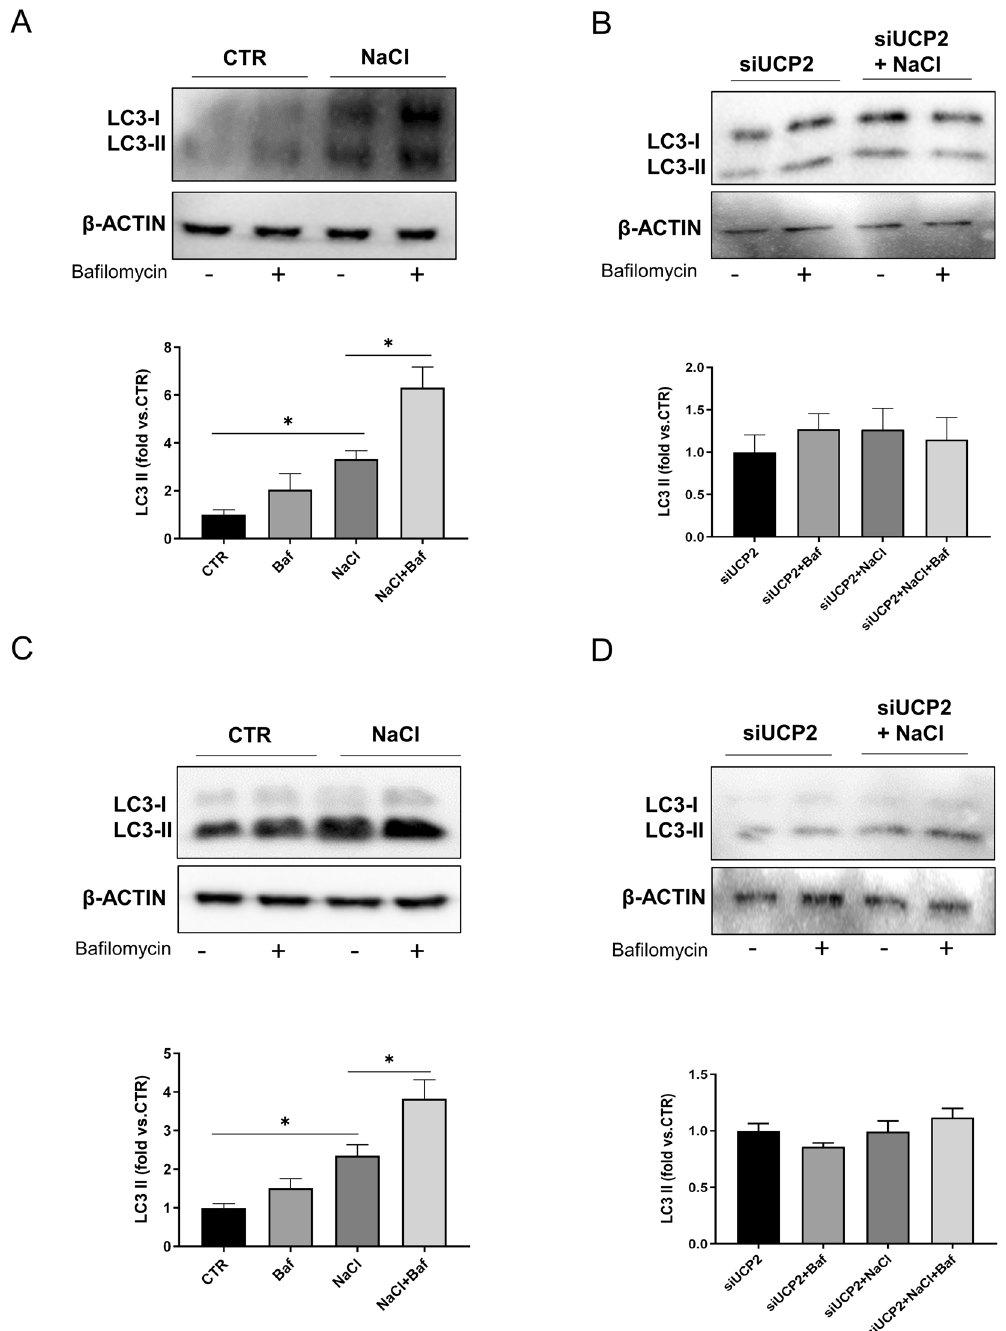
Fig. 3 Autophagic fl ux evaluation in UCP2-silenced cells exposed to high-salt. A Autophagic fl ux evaluation in microvascular brain endothelial cells exposed to high-salt (20 mM NaCl for 72 h) and treated for the last 3 h with 100 nM ba fi lomycin ( N = 4). B Autophagic fl ux evaluation in UCP2-silenced endothelial cells (siUCP2) exposed to high-salt (20 mM NaCl for 72 h) and treated for the last 3 h with 100 nM ba fi lomycin ( N = 4). C Autophagic fl ux evaluation in renal proximal tubular epithelial cells exposed to high-salt (20 mM NaCl for 72 h) and treated for the last 3 h with 100 nM ba fi lomycin ( N = 4). D Autophagic fl ux evaluation in UCP2-silenced renal proximal tubular epithelial cells (siUCP2) exposed to high-salt (20 mM NaCl for 72 h) and treated for the last 3 h with 100 nM ba fi lomycin ( N = 4). Representative western blots for LC3-I/II and corresponding quanti fi cation are reported. * p < 0.05, obtained using the one-way ANOVA followed by Bonferroni post hoc analysis. Data are reported as mean ±